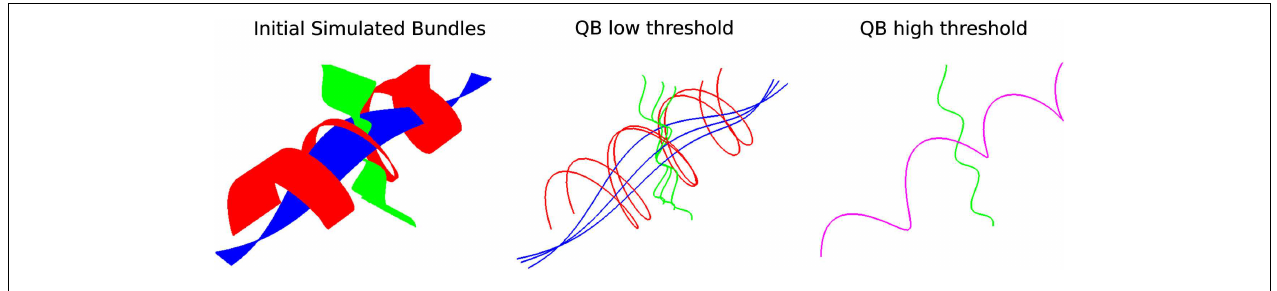
structure is reflected in a more detailed representation. At higher threshold, closer bundles merge together. Here the red and blue bundle have merged together in one cluster represented by the purple centroid streamline.